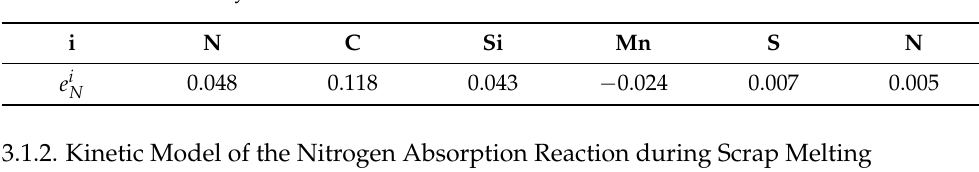
Table 5. Relative activity